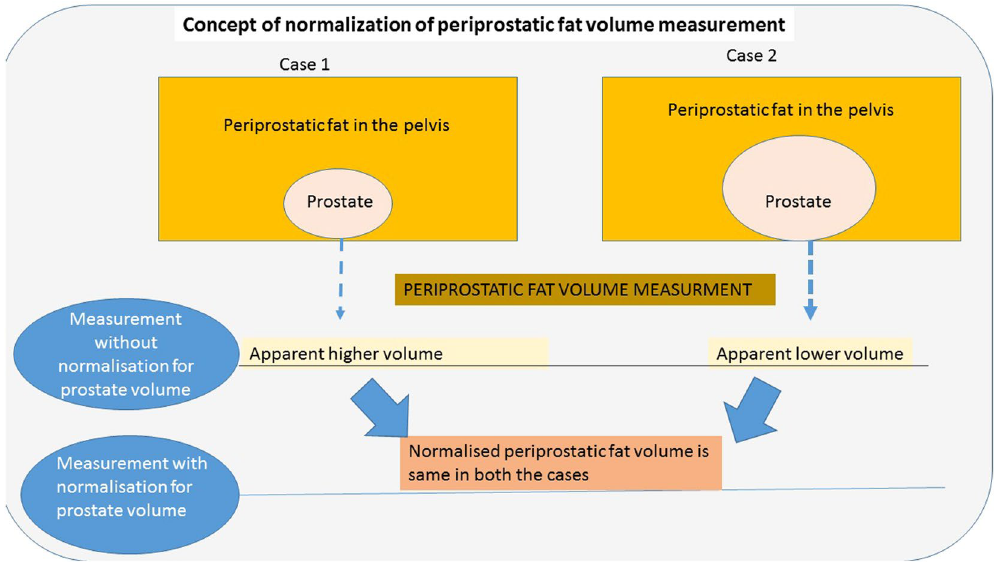
Figure 1. Schematic diagram explaining the concept of Normalised Periprostatic Fat Volume.